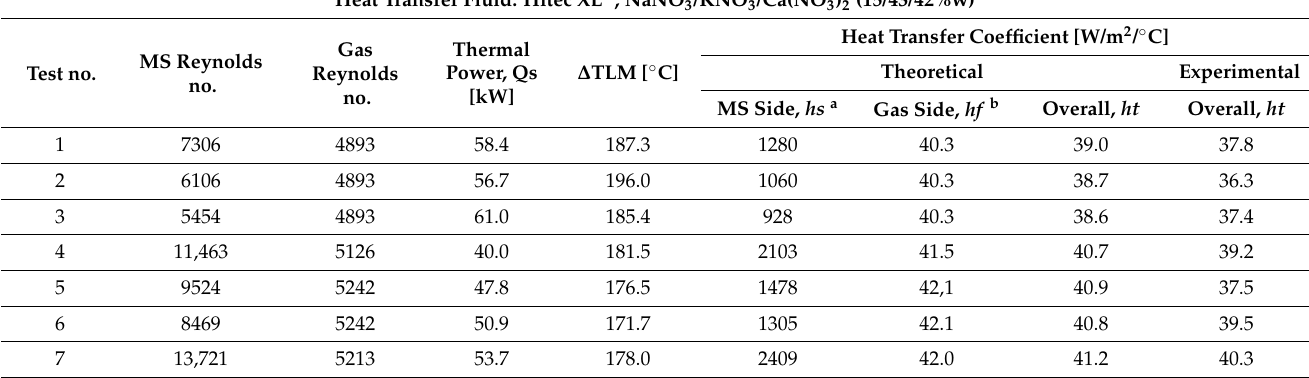
Table 5. Comparison between heat transfer coefficient determined experimentally (MSH prototype) and using relevant correlations: Dittus-Boelter equation (a) and correlations specific for banks of finned tubes [19] (b). All tests were carried out using LPG as gas fuel and the ternary Hitec XL ® mixture as HTF.